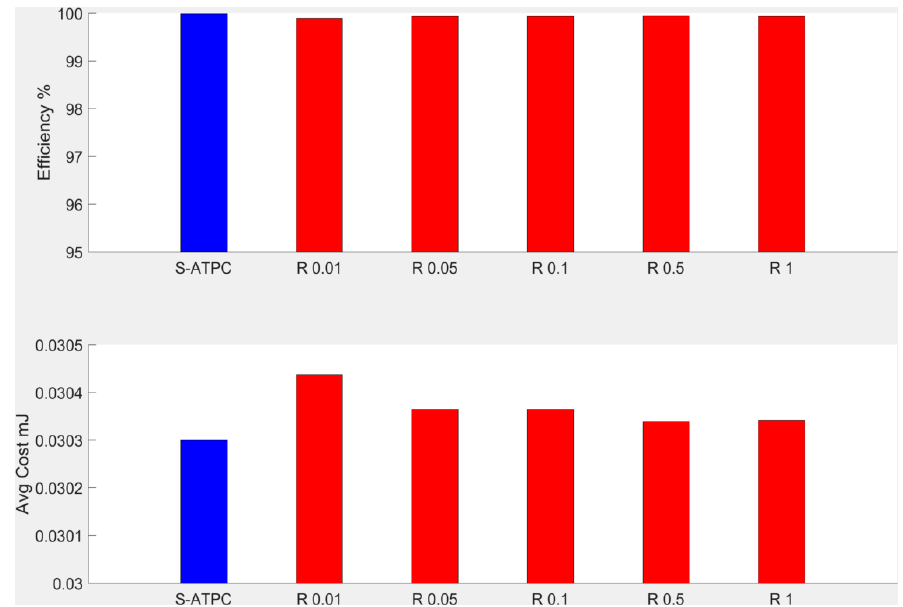
Figure 9. The protocol efficiencies and the average cost of success transmissions are compared when the PSR for all the cases are equal to 100%.